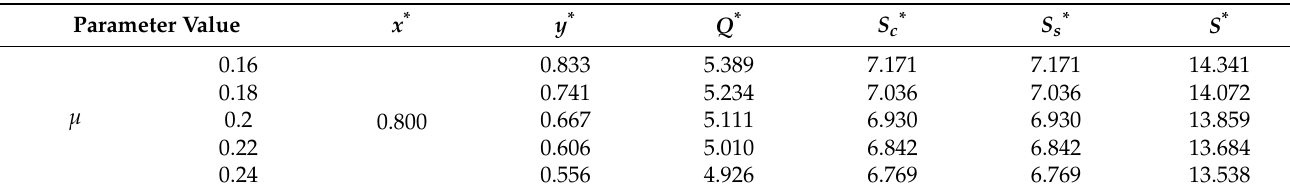
Table 6. Effect of quality cost coefficient µ on equilibrium